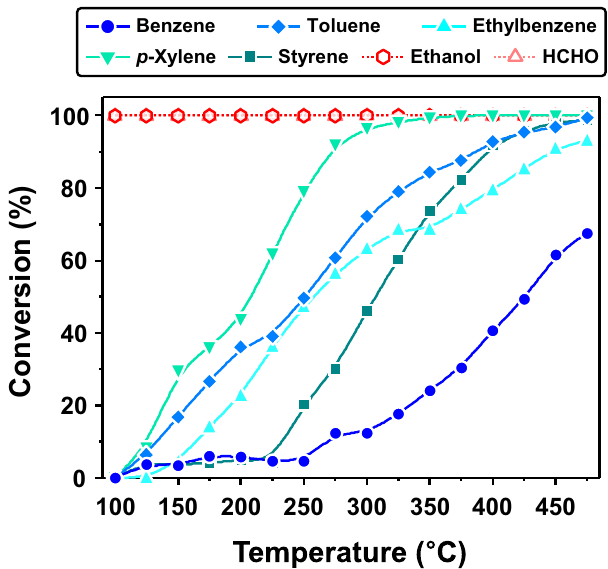
Fig. 6 | Catalytic performanceofCeO 2 . Catalyticconversion of 5ppmofdifferent analyte gases over CeO 2 catalyst as functions of temperature in the range 100 – 475°C. Source data are provided as a Source Data fi